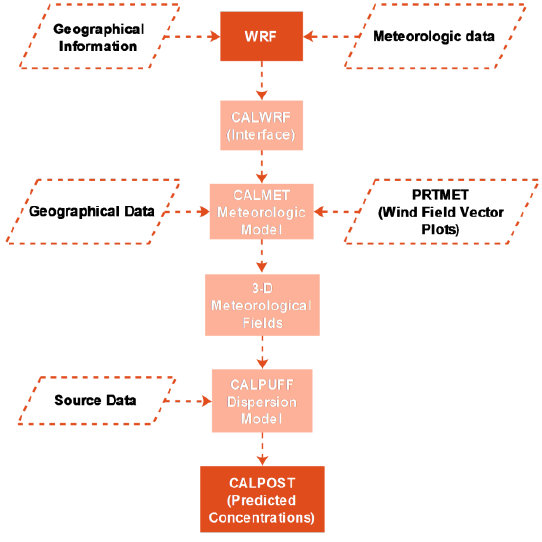
Figure 5. The process diagram of WRF–CALMET–CALPUFF modeling system.